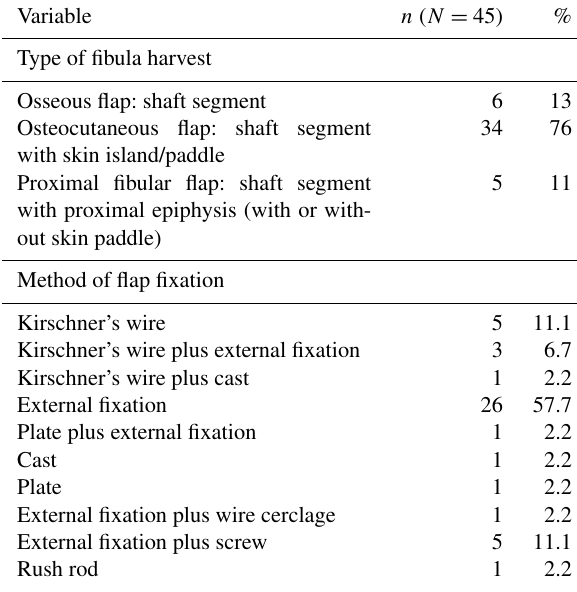
Table 3. VFF procedure